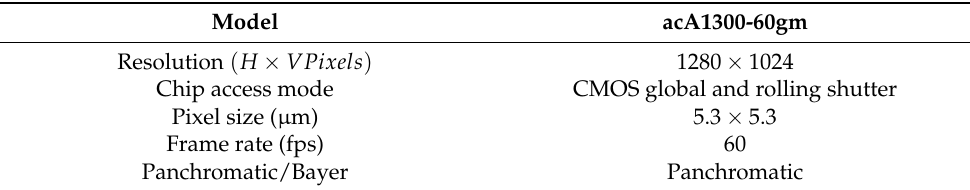
Table 1. Technical parameters of acA1300-60gm